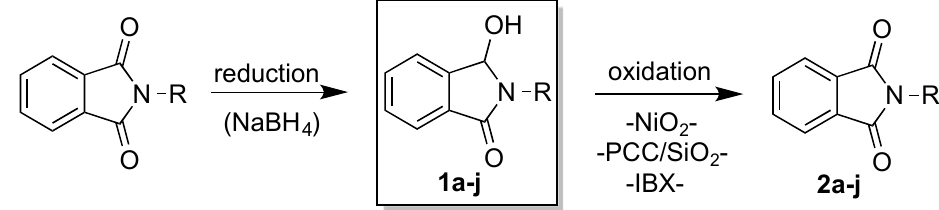
Scheme 1. Reduction-oxidation sequence between hydroxylactam and phthalimide substrates used for the oxidation study.